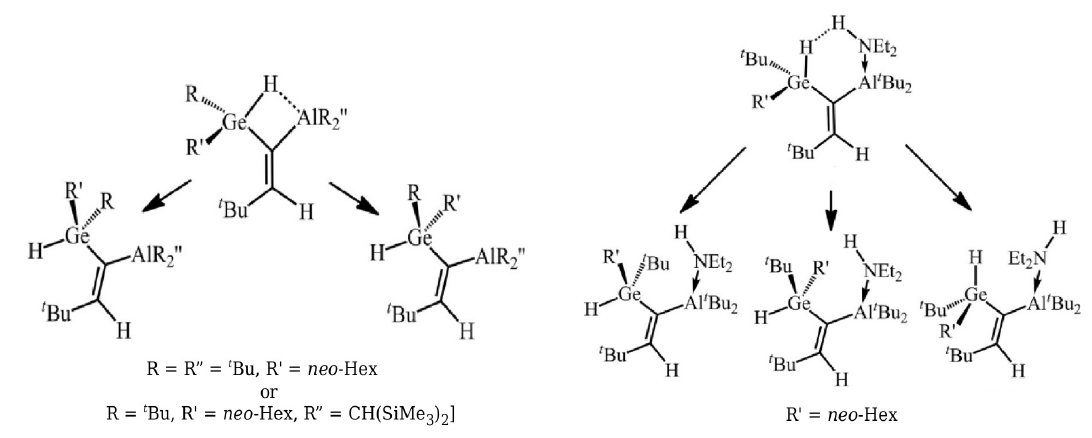
Figure 7. Closed and open forms investigated in ref.